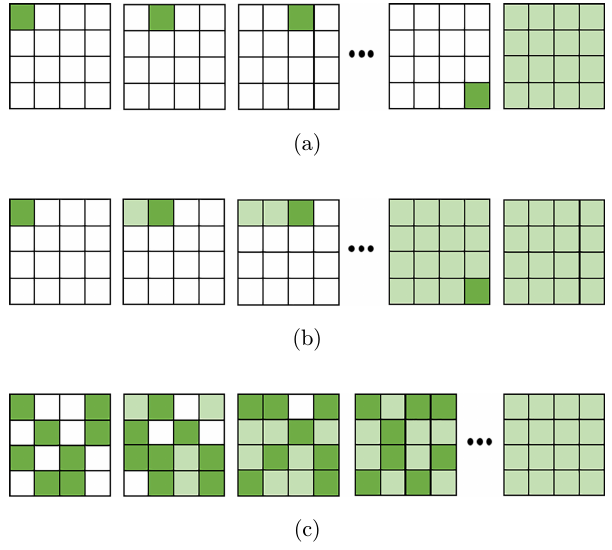
Fig. A.1. Principles of feedback-based iterative wavefront optimization algorithms SSA, CSA and PA. (a) Principle of SSA, which sequentially optimizes and records the phase of each segment, and ¯nally updates the optimized phases of all segments on the spatial light modulator. (b) Principle of CSA, which is the same as SSA except for that the modulator refre- shed immediately after the phase of each segment is optimized. (c) Principle of PA, which randomly selects and optimizes the phases of a half of all segments and updates the spatial light modulator in each iteration. Light green indicates segments to be optimized, and dark green indicates segments which have been